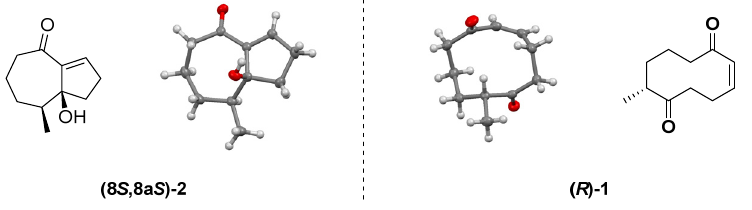
1 Reactions performed at 0.1 mmol scale employing 10 mol% of catalyst and 50 mol% of phenol in CHCl 3 (0.1 mmol/mL) at room temperature. Diastereomeric ratio for product 2 was >15:1 in all the cases. Yields refer to isolated pure products. 2 Calculated by HPLC on chiral stationary phase. 3 Reac- tions performed at 0.8 mmol scale.